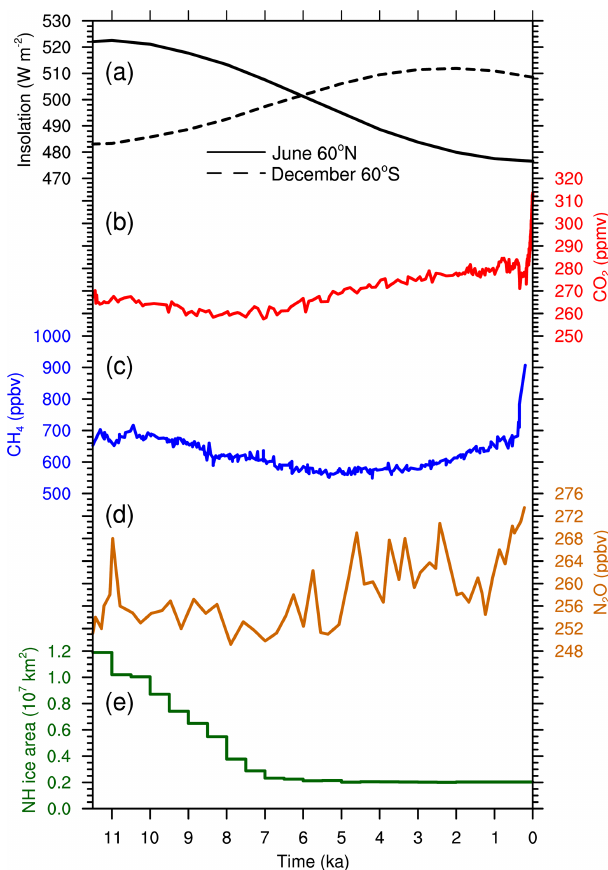
Figure 1. Temporal evolution of the external forcings in the HT- 11.5ka simulations since the Early Holocene (11.5ka), for (a) June insolation at 60 ◦ N (solid line) and December insolation at 60 ◦ S (dashed line; Berger, 1978), (b) atmospheric CO 2 concentration (re- cent composite of EPICA Dome C, Law Dome, and West Antarctic Ice Sheet Divide records, Antarctica; Bereiter et al., 2015), (c) at- mospheric CH 4 concentration (EPICA Dome C, Antarctica; Louler- gue et al., 2008), (d) Atmospheric N 2 O concentration (Talos Dome, Antarctica; Schilt et al., 2010), and (e) area of the ice sheets in the Northern Hemisphere, according to the ICE-6G_C reconstruction (Argus et al., 2014; Peltier et al., 2015).